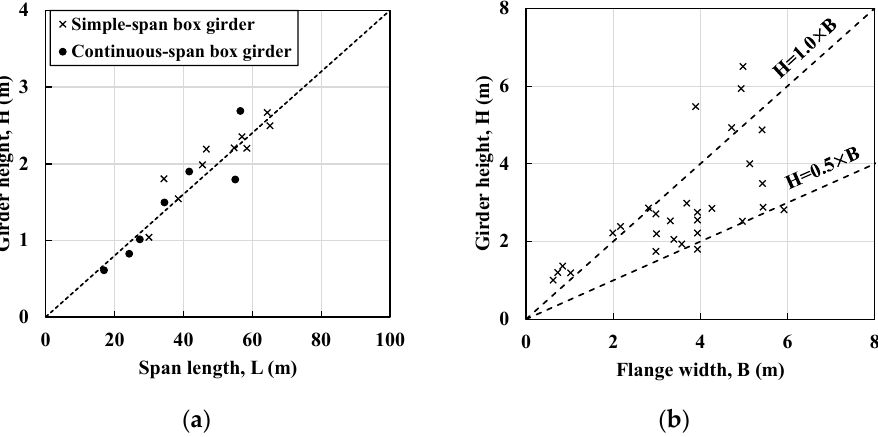
Figure 3. Practical bridge data: ( a ) girder height-to-span ratio and ( b ) girder height-to-flange width ratio [28] .